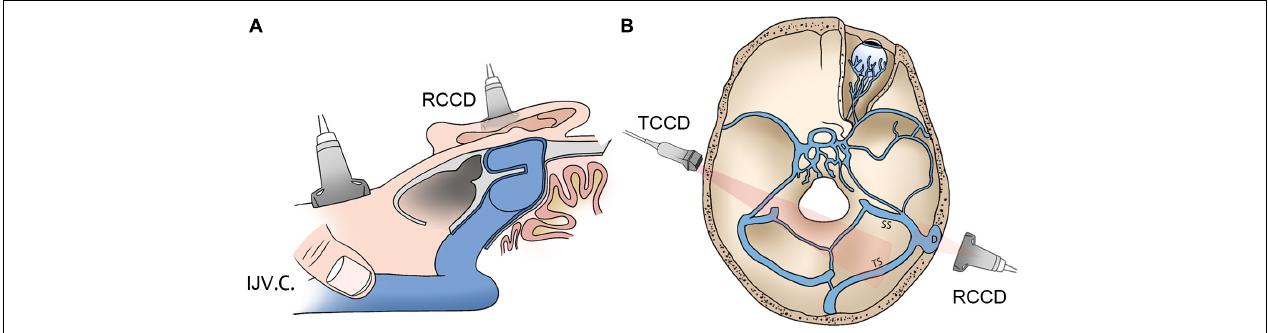
FIGURE 1 | Schematic diagrams of RCCD and TCCD application. (A) Assessment of hydroacoustics and PT using RCCD and IJV compression. (B) The TCCD technique for hemodynamic assessment of contralateral transverse sinus. RCCD, retroauricular color-coded Doppler; TCCD, transcranial color-coded Doppler; and PT, pulsatile tinnitus; IJV.C., internal jugular vein